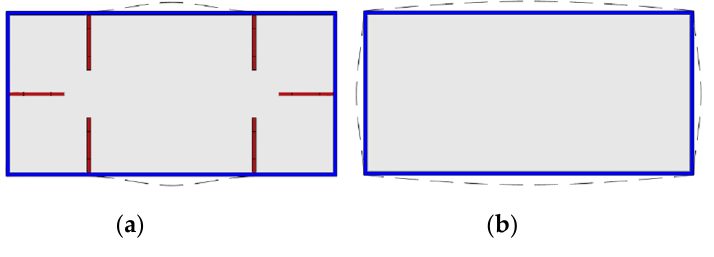
Figure 4. Appearances of the responding rectangular-section. ( a ) Stiffened specimen; ( b ) unstiffened specimen.